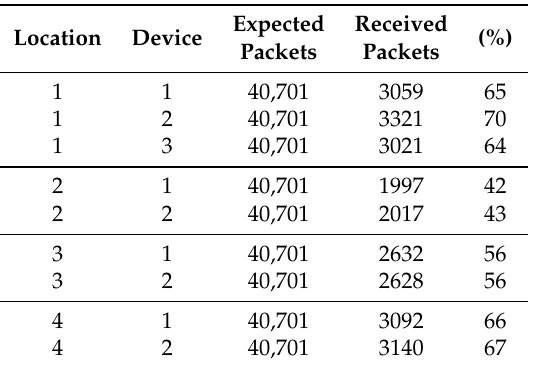
Table 1. Percentage of received packets based on the manufacturer’s setting for hourly broadcasts. Expected Received Location Device Packets Packets